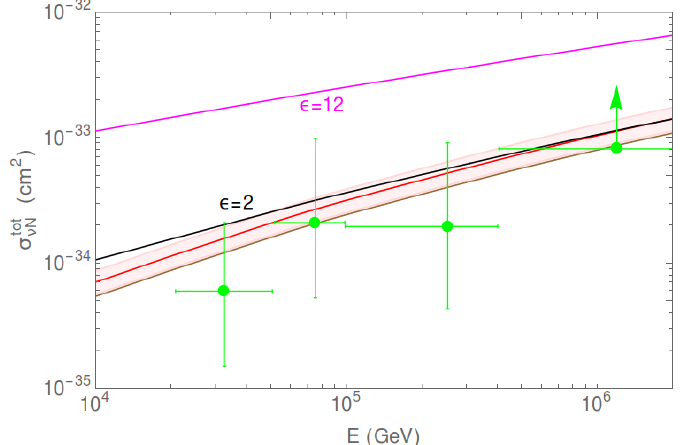
Figure 1 . Constraints on NSI described by eq. (4.1) for m Z 0 = 5 GeV. The brown line represents the total SM neutrino-nucleon cross-section [64]. The red line and the light red band denote the central value and 1 (cid:27) allowed range of (cid:27) tot from IceCube observation of track events respectively [32]. (cid:23)N Similarly, the green points and related error bars in the y -direction stand for the central values and 1 (cid:27) allowed ranges in (cid:27) tot measured from the IceCube observation of shower events at di(cid:11)erent (cid:23)N energy bins respectively [42]. In presence of a Z 0 with mass m Z 0 = 5 GeV and interactions as in eq. (4.1), ( i ) the magenta line depicts the value of (cid:27) tot with the NSI parameter (cid:15) set at its maximum (cid:23)N allowed value from LHC, (cid:15) = 12, ( ii ) the black line represents the value of (cid:27) tot with (cid:15) set at its (cid:23)N maximum allowed value from IceCube, (cid:15) =